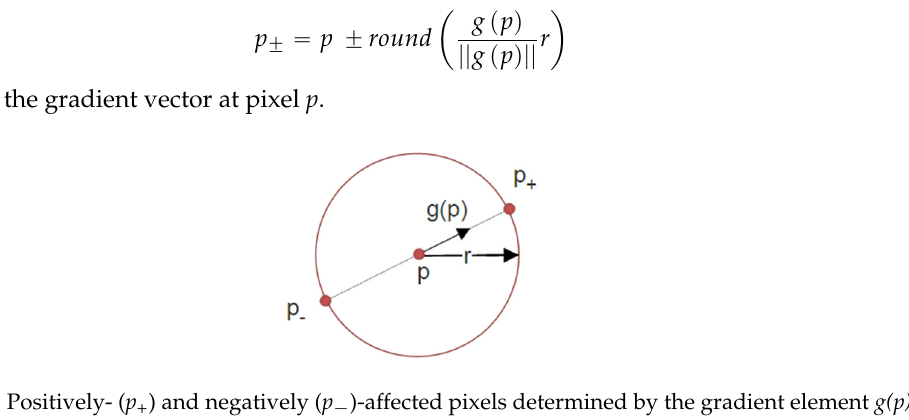
Figure 3. Positively- ( p + ) and negatively ( p − )-affected pixels determined by the gradient element g(p) for a radius r (after [23]).